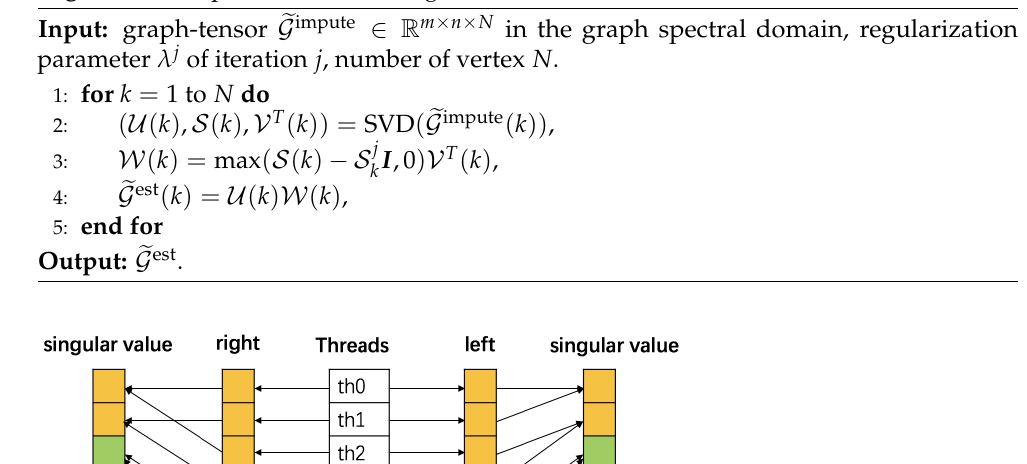
Algorithm 2 Implementation of singular value soft-threshold.